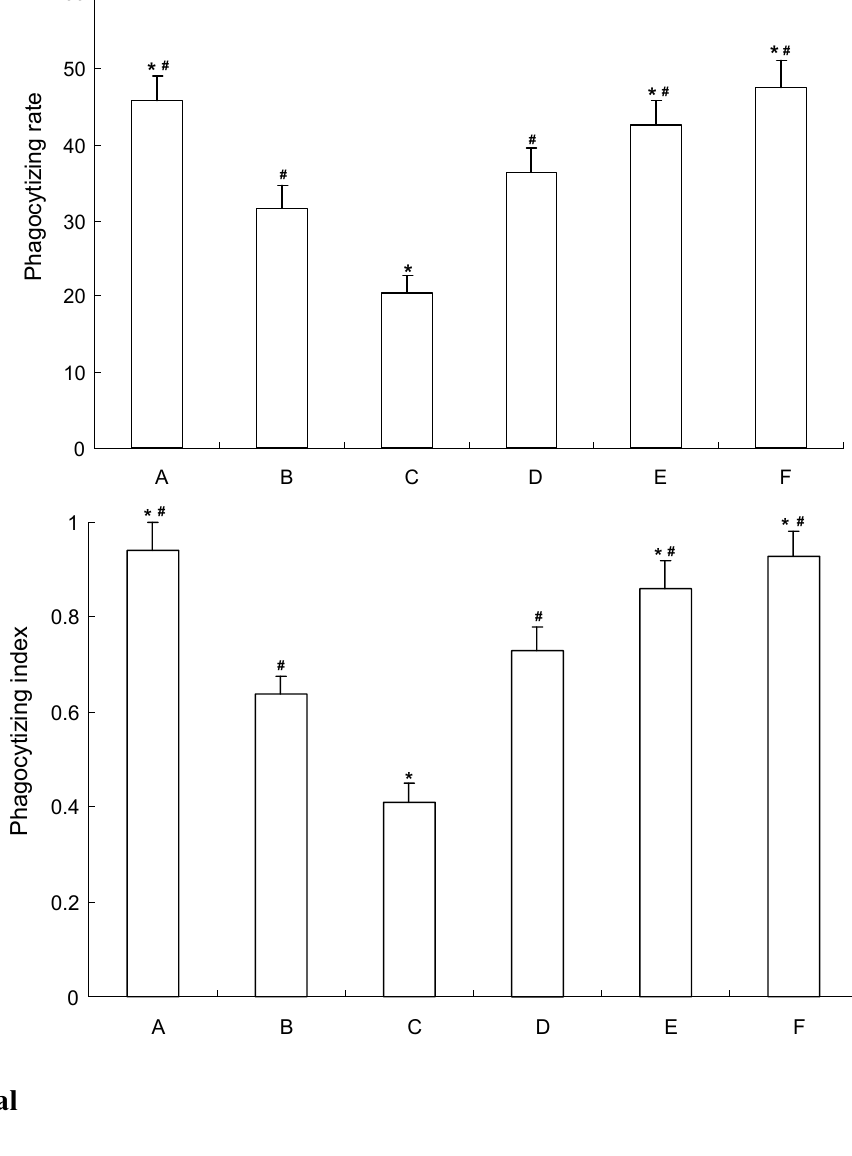
Figure 5. Influence of CE-SB on phagocytotic function of macrophage of H22 bearing mice. Group A: normal control; Group B: tumor control; Group C: 5-FU; Group D: low dosage CE-SB; Group E: medium dosage CE-SB; Group F: high dosage CE-SB. * P < 0.05 vs. tumor control group; # P < 0.05 vs. 5-FU